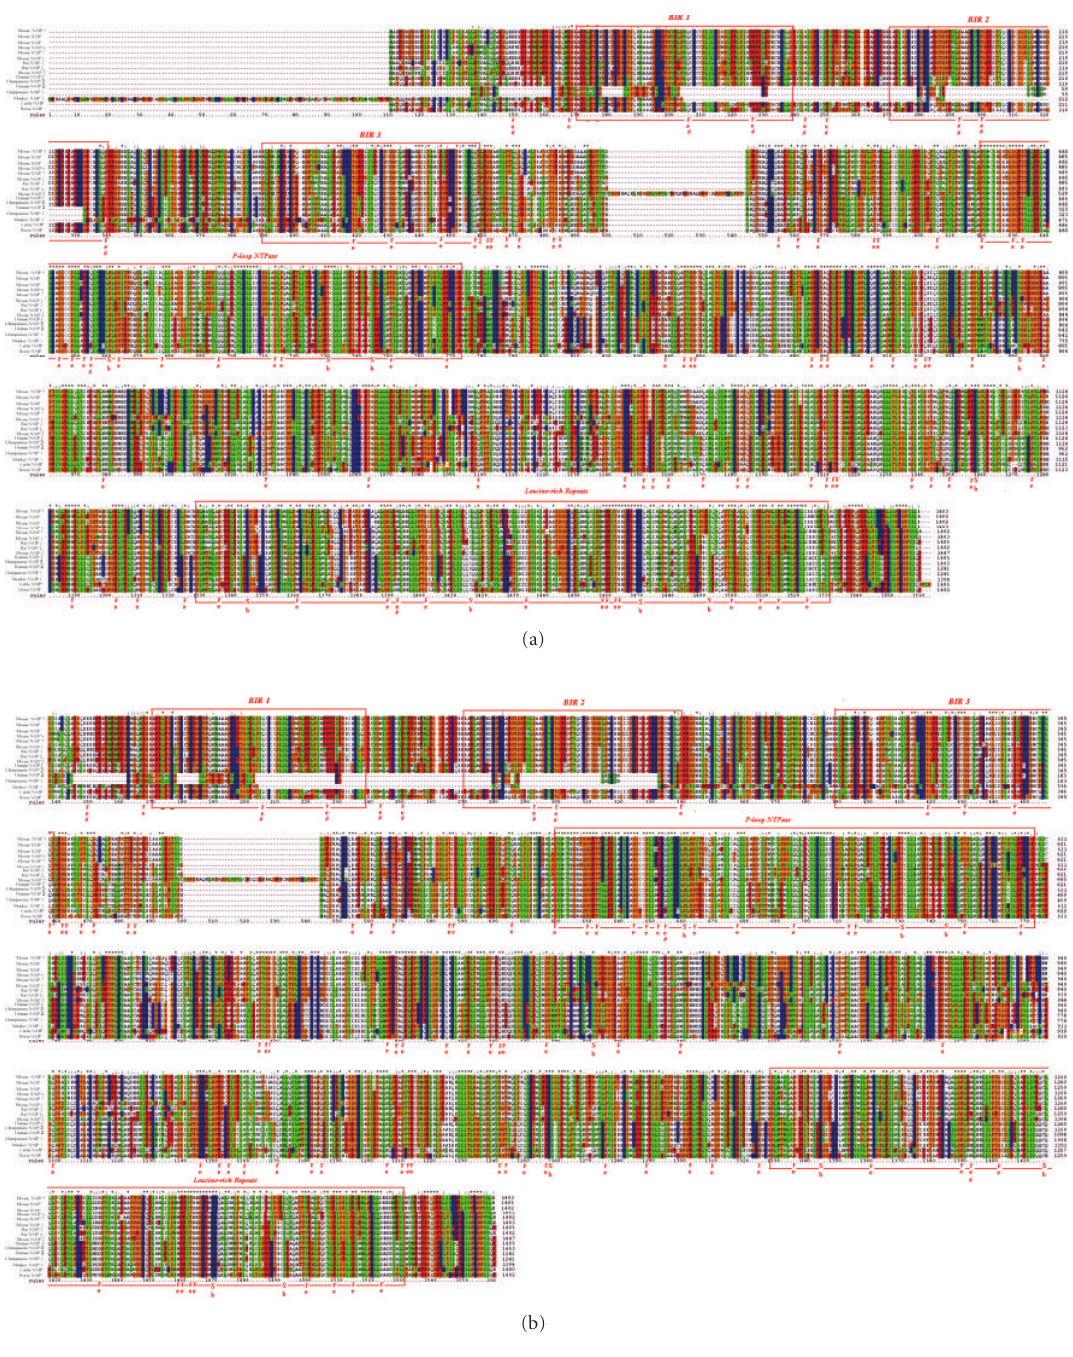
Figure 1: Manually corrected alignments. (a) Alignments before manual correction; (b) Alignments after manual correction. Alignment were constructed using Clustal X and modified with Boxshade (http://www.ch.embnet.org/software/BOX form.html). Functional domains are designed as BIR, P-loop NTPase, and LRP. “ ∗ ” indicated highly conserved residues. Functional (f) or structural (s) residues (f indicates highly conserved and exposed, s indicates highly conserves and buried); “ # ” indicates amino-acids had changed during the evolution.